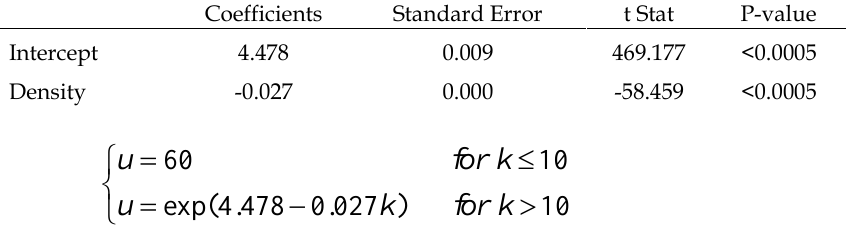
Table 2. Case study I the second cluster fitted results of two clusters